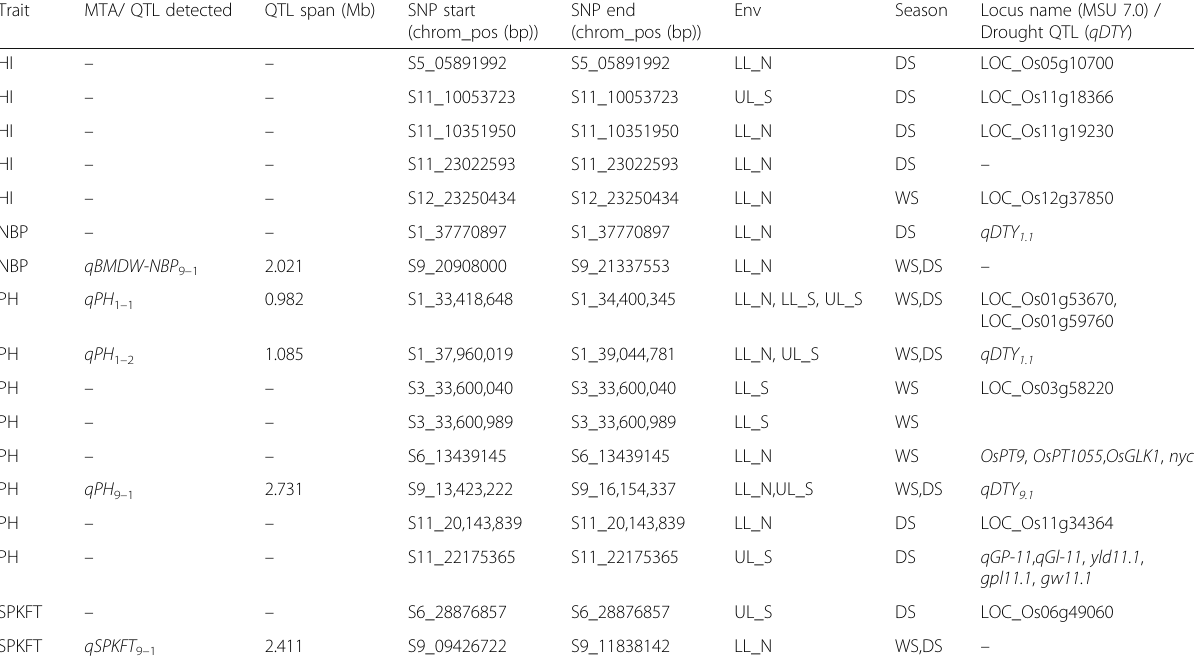
Table 3 Summary of candidate gene analysis for seven traits in different seasons and environments validated for genes and qDTY regions (Continued)